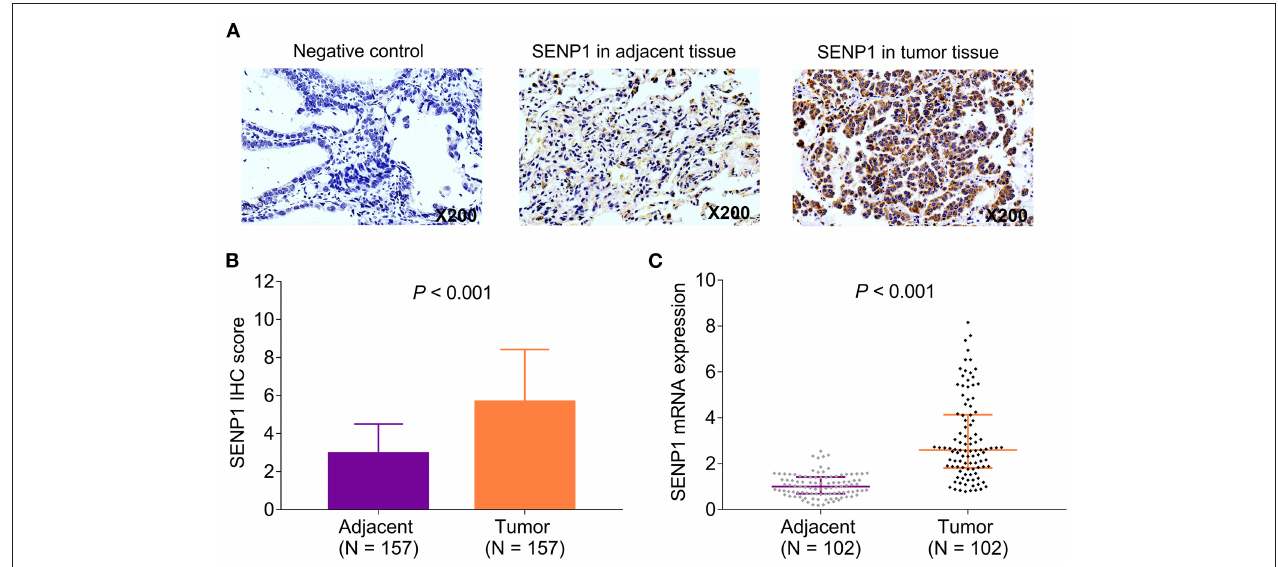
FIGURE 1 | SENP1 expression in patients with surgical NSCLC receiving adjuvant chemotherapy. Examples of SENP1 IHC staining in negative control, adjacent tissues, and tumor tissues (A) comparison of SENP1 IHC score (B) and SENP1 mRNA expression (C) between the tumor tissues and the adjacent tissues. SENP1, small ubiquitin-like modifier (SUMO)-specific protease 1; IHC, immunohistochemistry; NSCLC, non-small cell lung cancer.